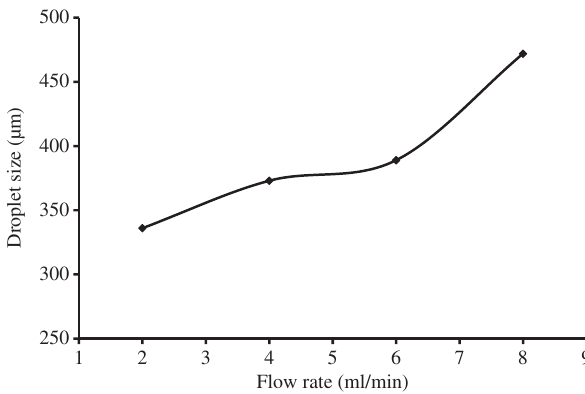
Figure 5: Effect of precursor concentration on droplet size (flow rate = 2 ml/min, power of atomization = 39 W).